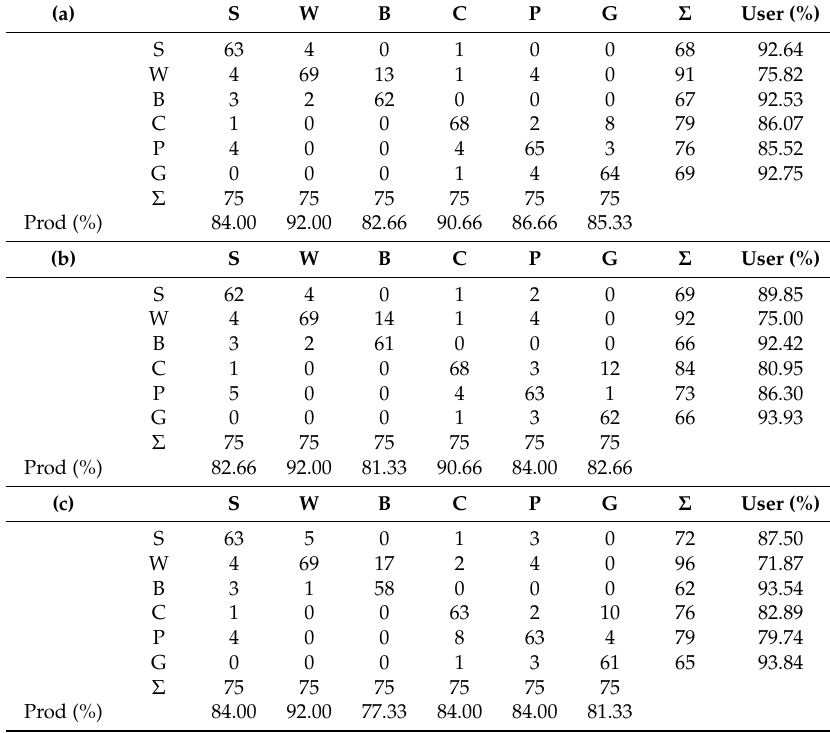
Table 12. Confusion matrices for classifications by discriminant analysis using training sets containing cases mislabelled to a similar class: ( a ) 5% error; ( b ) 10% error; and ( c ) 20%